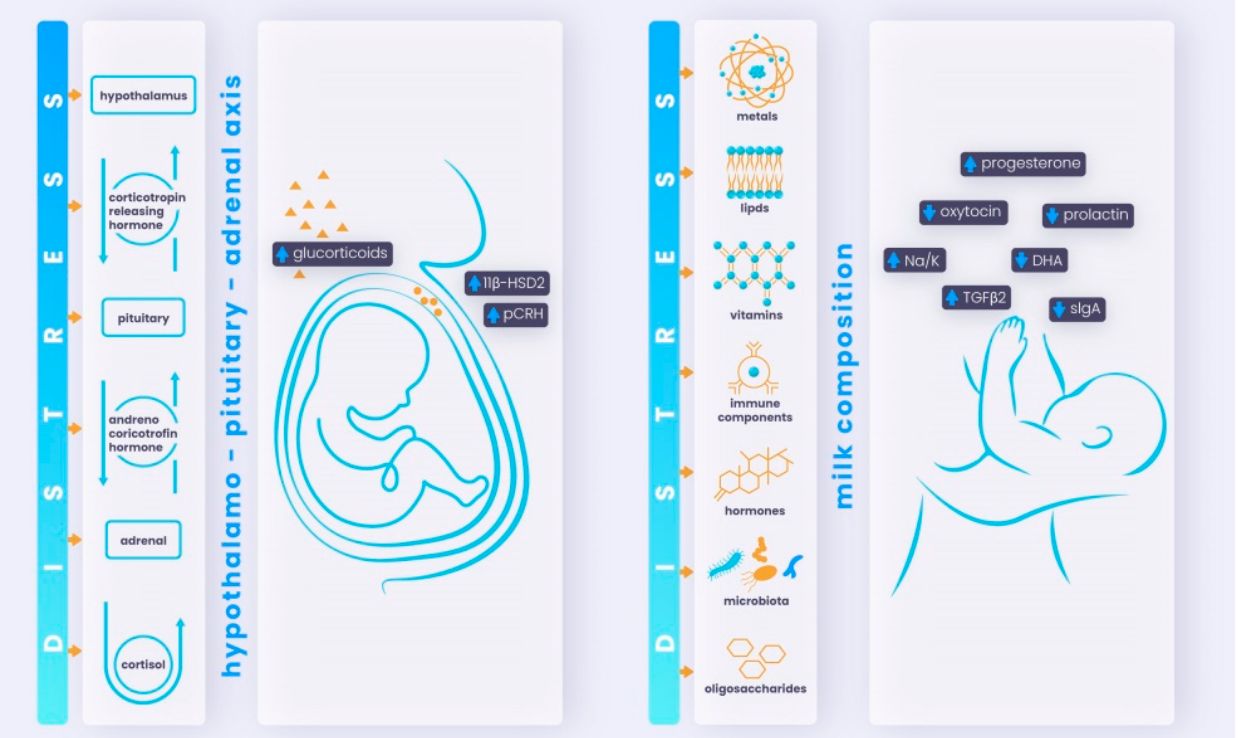
Figure 1. Maternal distress transmission: placental and breastfeeding mechanisms.